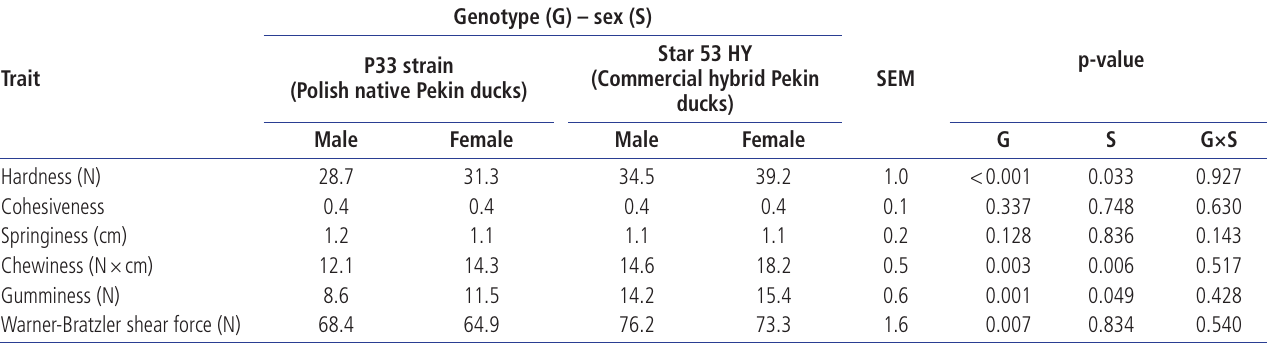
Table 7. Textural traits of pectoralis major muscle from 49-d-old Pekin ducks of different genotypes